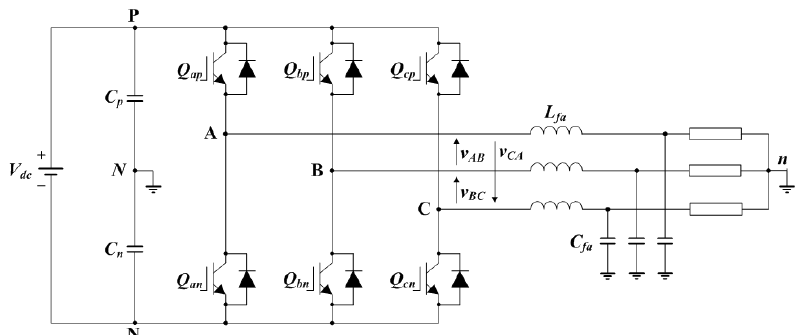
Figure 2. Circuit configuration of three-phase 3-leg inverter employing split DC-link capacitors.